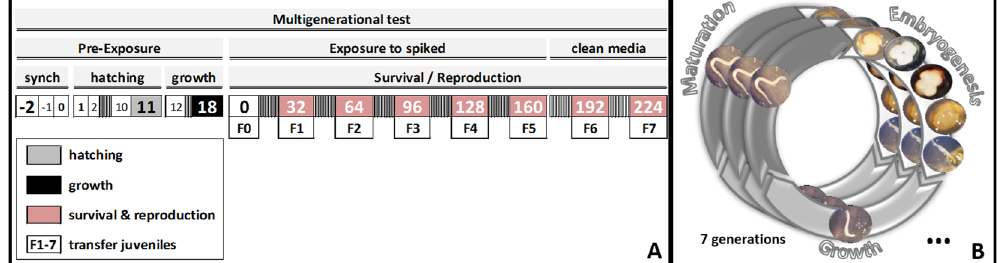
Test materials and spiking.